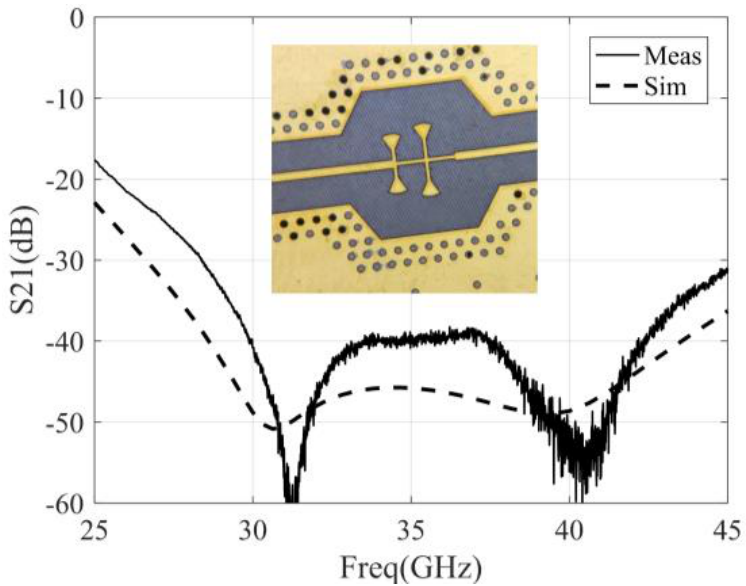
Figure 8. The simulation and measurement results of the LPF at the output of the